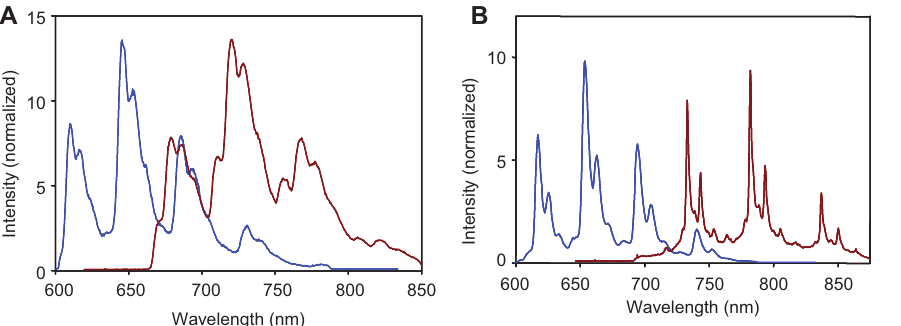
Figure 10 Low temperature (8 K) luminescence spectra of microcrystalline: (A) [ReO and (B) [ReO (pic) ](BPh ) ( ▬▬ ) and [TcO 2 4 4 Heineman, W.R.; Sullivan, B.P.; Hightower, S.E.; Hubler, T.L.; Bryan, S.A. J. Am. Chem. Soc. 2005 , 127 , 14978. ” Copyright © 2005, American Chemical